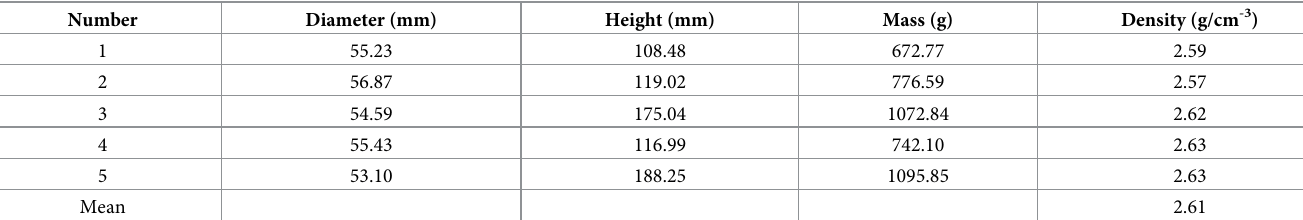
Table 2. Density experiment results of sandstone